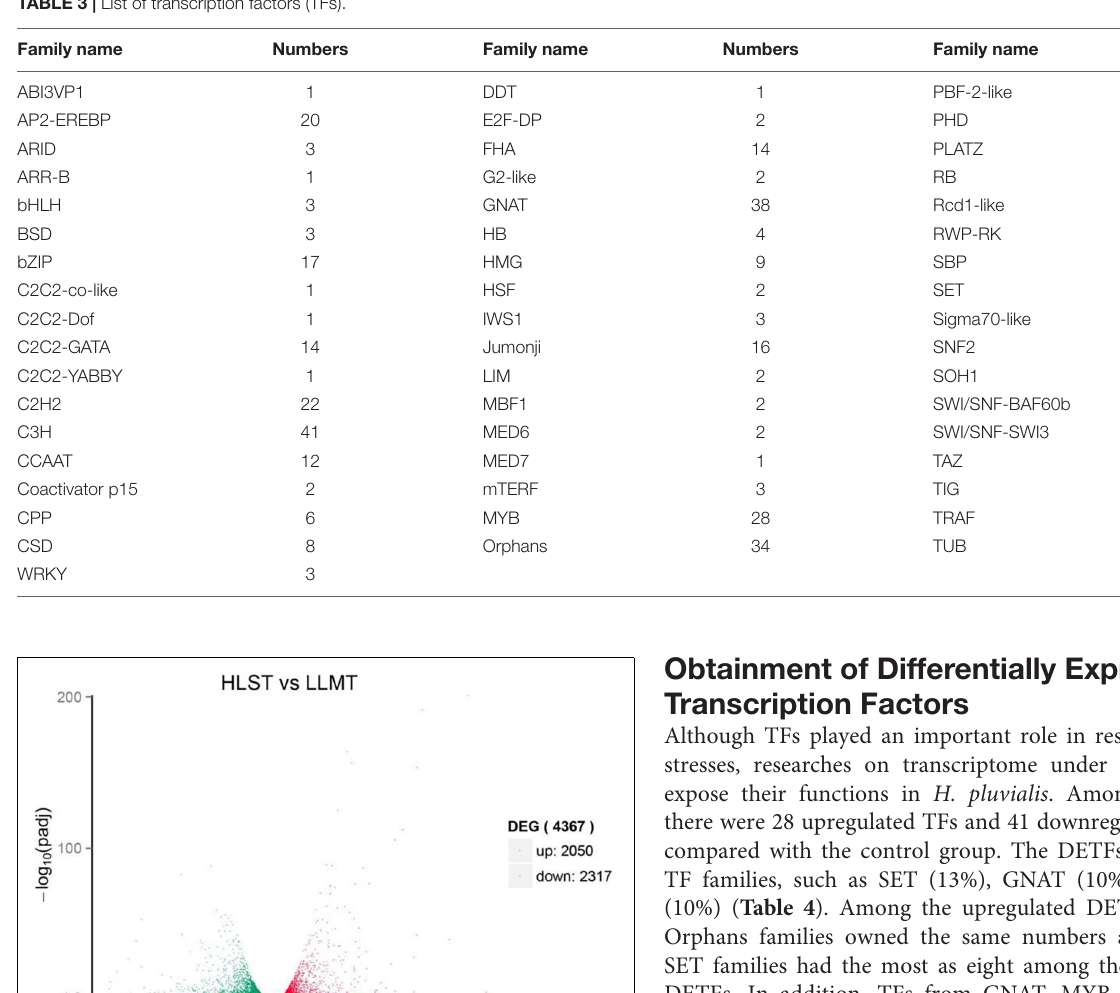
TABLE 3 | List of transcription factors (TFs).